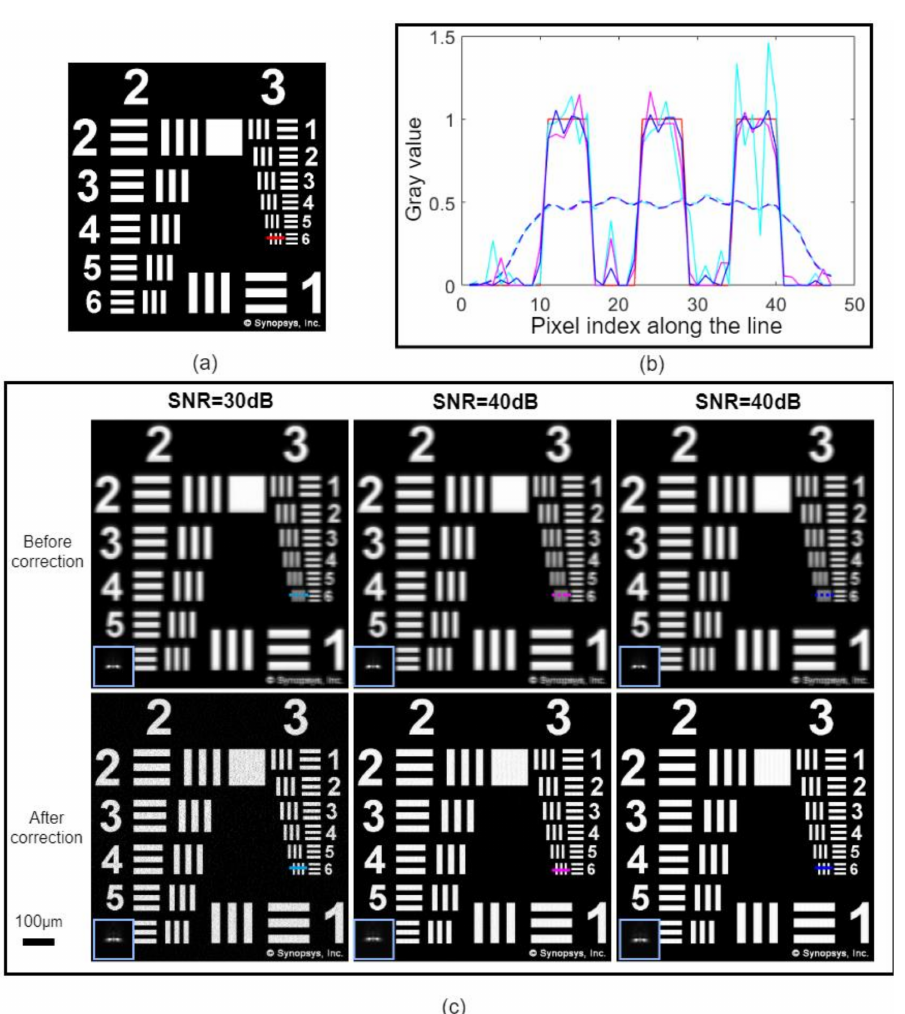
Figure 6. Simulation results of aberration correction: ( a ) original image reprinted with permission from Synopsis, Inc., ( b ) the line outline of the periodic line in ( c ). ( c ) The results before and after the correction of images with different noise levels are compared, and the inset boxes show the used measured